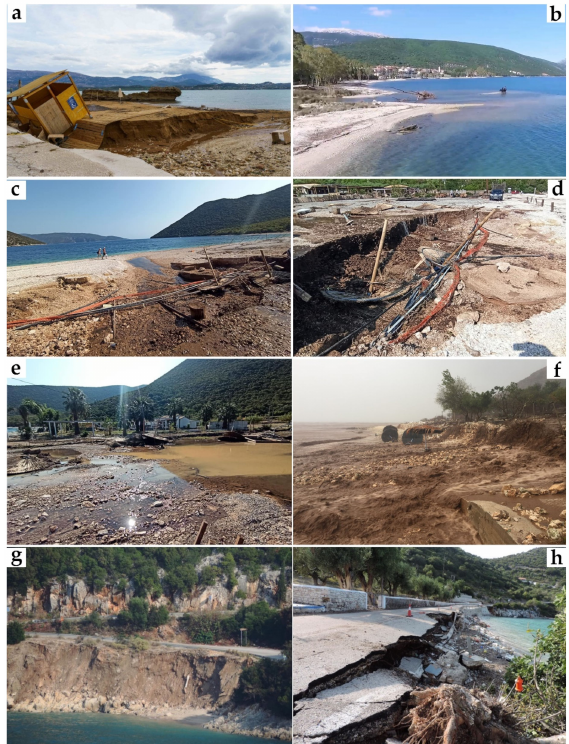
Figure 9. Characteristic images of the geomorphic impacts of Ianos Medicane on coastal zones of Ithaki, Cephalonia, and Zakynthos showing ( a – e ) scouring segments of the beach, ( f ) beach scouring and recession, ( g ) wave cutting at the base of the cliff and ( h ) wave undercutting a road embankment.